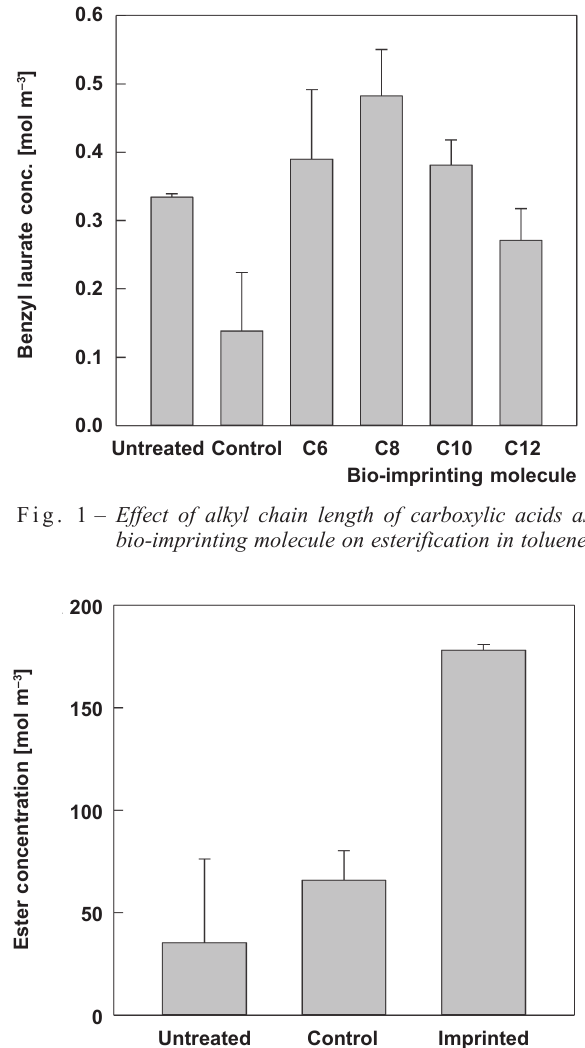
Fig. 2 – Effect of lipase imprinting on solvent-free esterifica- tion (molar ratio of isoamyl alcohol to propionic acid = 3, es- ter concentrations are at 24 h)